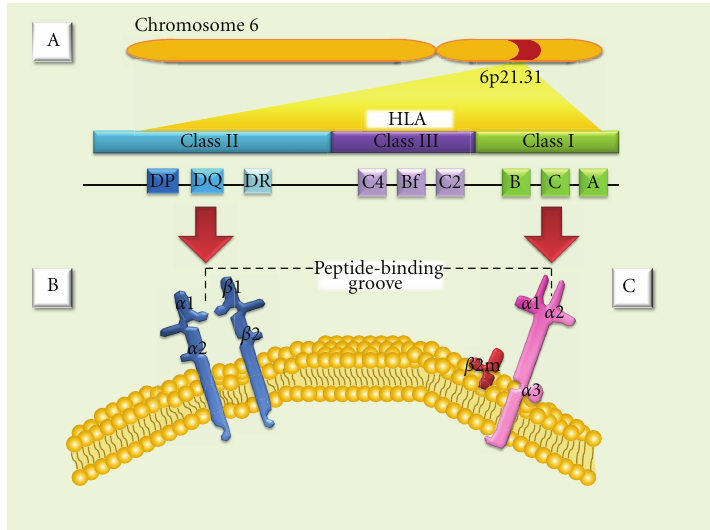
Figure 1: (A) MHC (major histocompatibility complex). (B) Class II antigens are expressed only on B lymphocytes, activated T lymphocytes, monocytes, macrophages, Langerhans cells, dendritic cells, endothelium, and epithelial cells. They are heterodimers composed of noncovalently associated α and β polypeptide chains chains encoded by genes of the HLA-D region. (C) Class I MHC antigens are present on all nucleated cells and are composed of a 45-kd transmembrane α heavy chain encoded by genes of the HLA-A, HLA-B, or HLA-C loci on chromosome